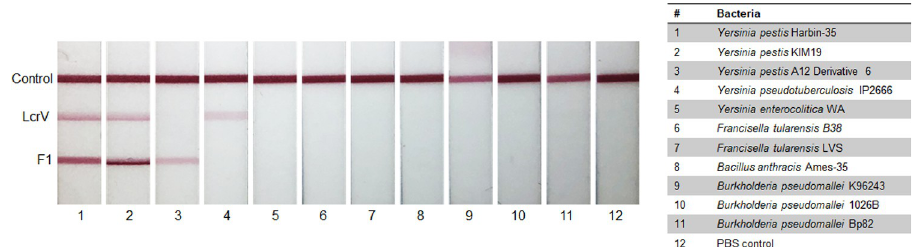
Fig 4. Specificity testing of dual Yersinia pestis lateral flow immunoassay (LFI) against clinically relevant bacterial panel. The dual LFI prototype containing test lines specific for LcrV (8F10/6F10) and F1 (11C7/3F2) was tested against a panel of bacterial lysates. Bacterial lysate (50 μ L at OD 600 = 0.5) was applied onto the conjugate pad and chased with buffer. LFIs were imaged after 20 minutes.